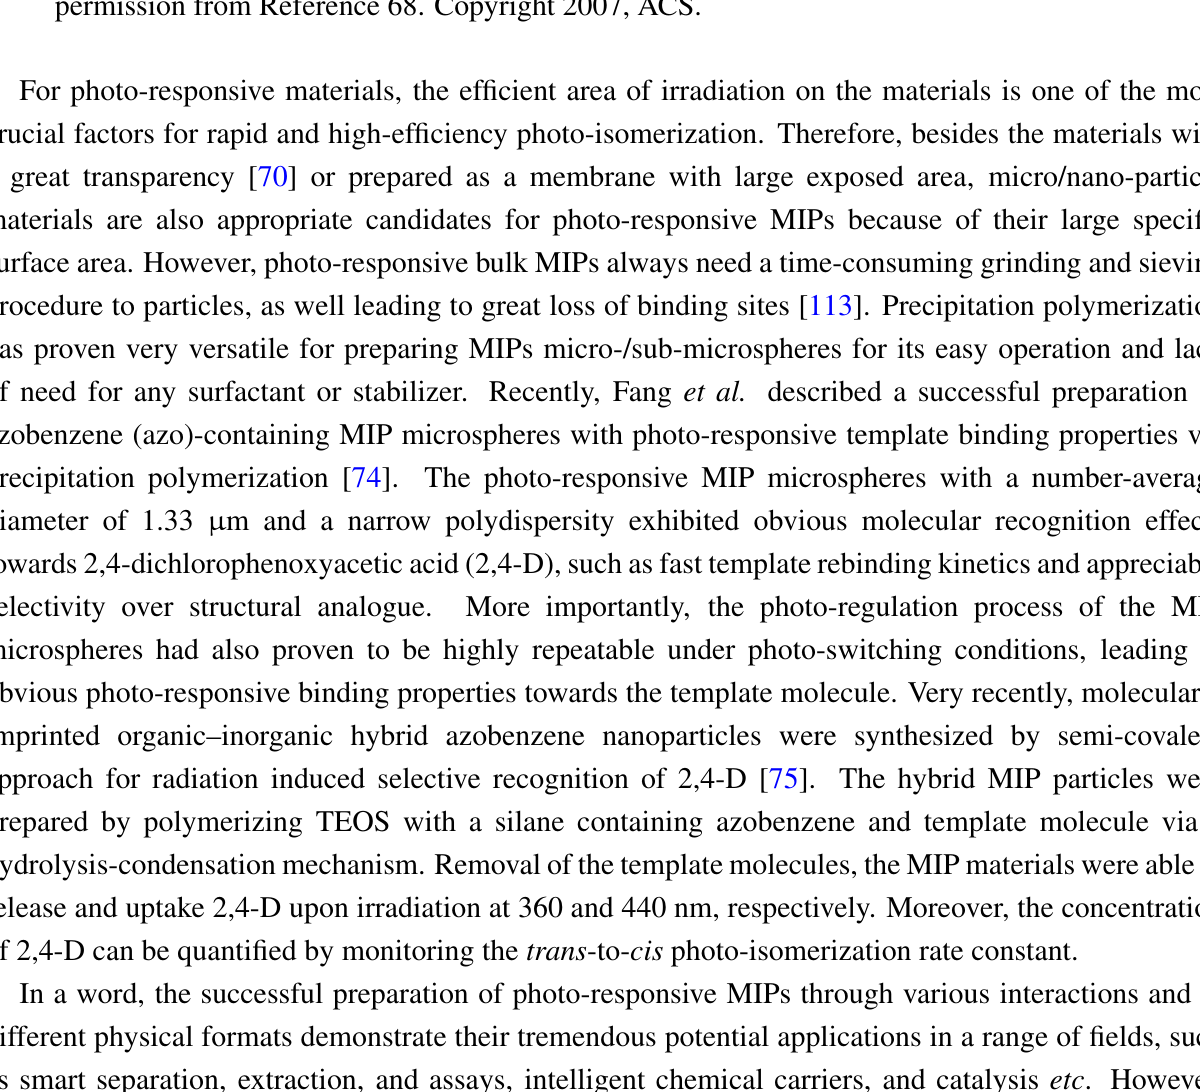
Figure 8. Photoisomerization of the MIPs matrix allowed switching the substrate affinity by altering the geometry and spatial arrangement of the receptor binding sites. Reprinted with permission from Reference 68. Copyright 2007, ACS.